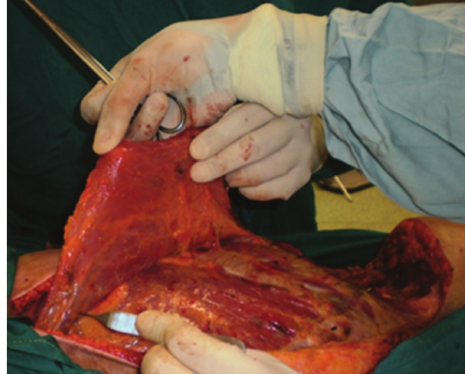
Figure 6: Identification of the thoracodsorsal pedicle.